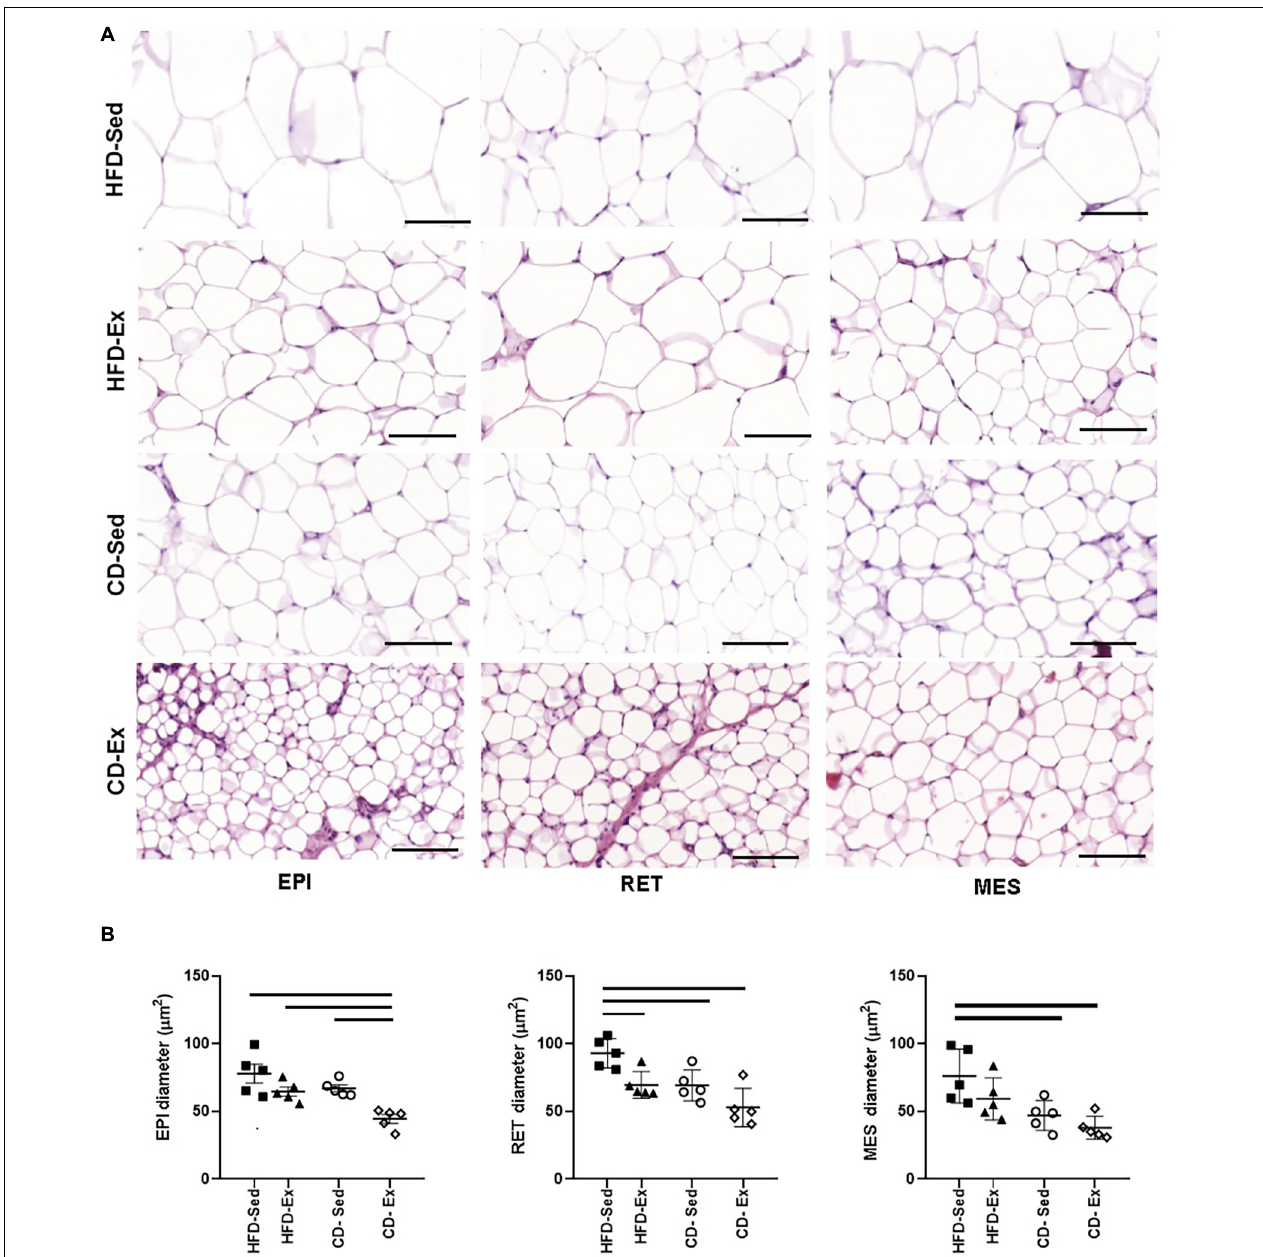
FIGURE 3 | Photomicrograph of adipose tissue after 8 weeks of dietary intervention and training. (A) Representative images of adipose tissue showing hematoxylin and eosin staining using 20 × (100 µ m) objective, light-field microscopy. (B) Diameter of EPI, RET and MES adipocytes; RET: retroperitoneal adipose tissue; MES: mesenteric adipose tissue. HFD-Ex: trained high-fat diet group; HFD-Ex: high-fat diet and exercise; HFD-Sed: sedentary high-fat diet; CD-Ex: chow diet and exercise; CD-Sed: sedentary chow diet. The bars represent the significant differences between the indicated groups. The results are presented as means ± SEM ( p <